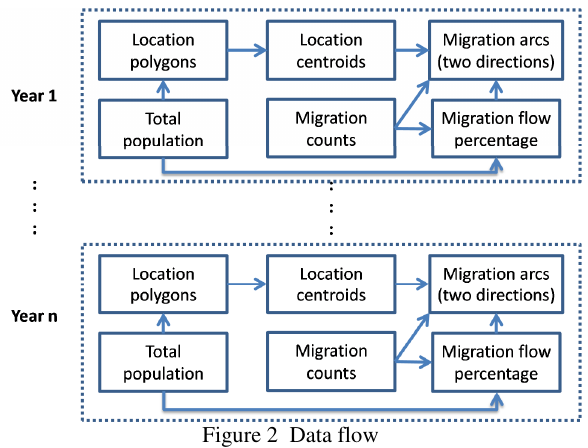
Figure 2 Data flow